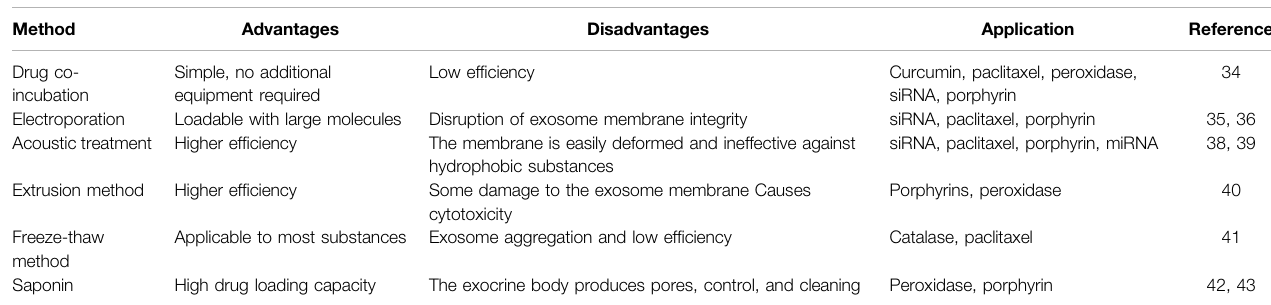
TABLE 1 | Advantages, disadvantages, and applications of various extracellular drug delivery